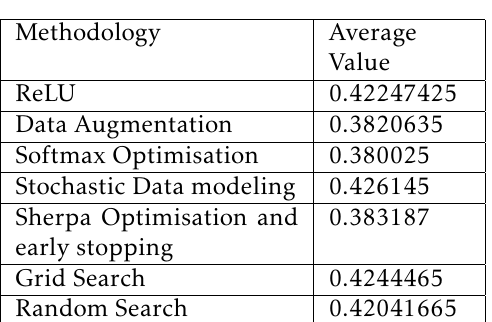
Table 4. Optimisations and Regularisations of Capsnets on CIFAR-10 dataset with respect to loss parameter